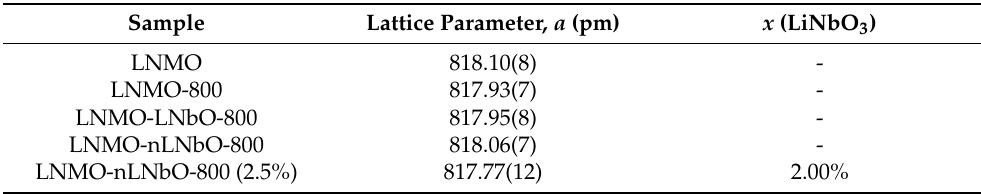
Table 1. Results of the Rietveld refinement of the lattice parameter a of LNMO and phase fraction of LiNbO 3 after coating with 2.5 wt.% LiNbO 3